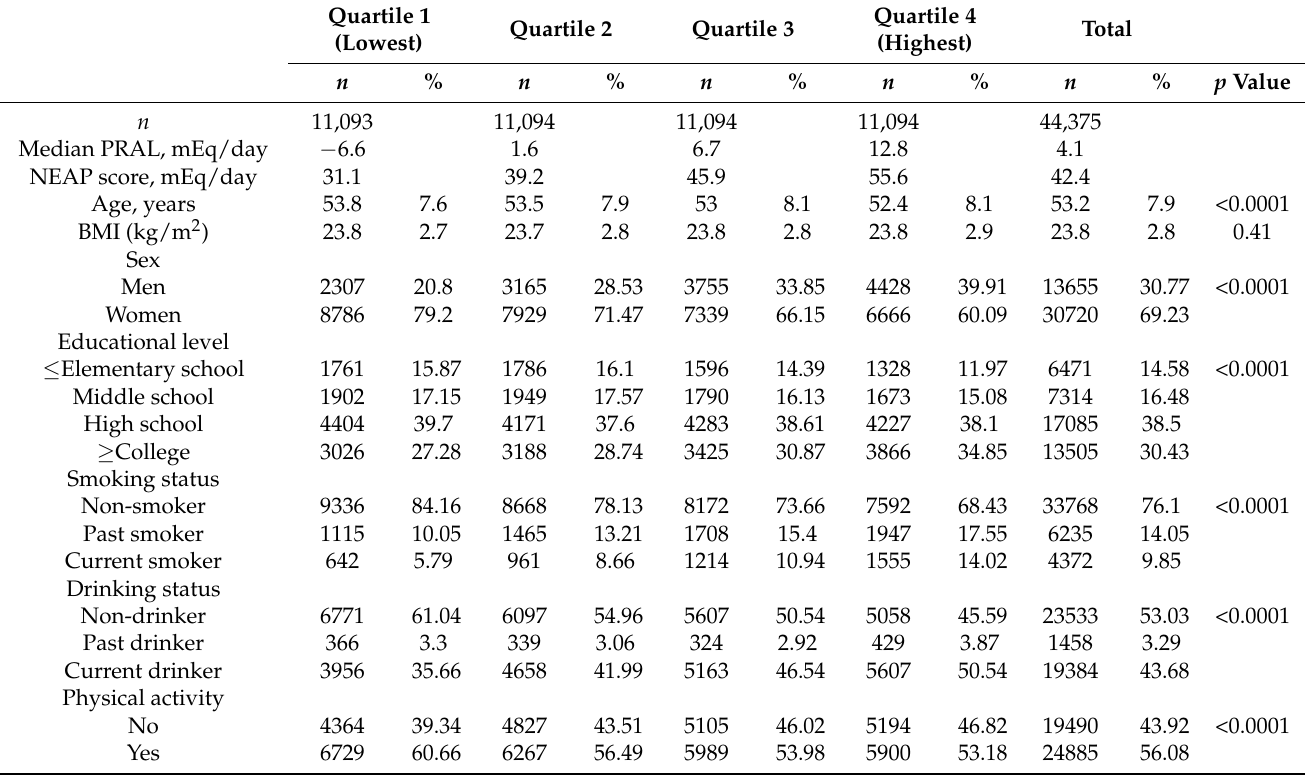
Table 1. Characteristics of the study participants at baseline according to the quartiles of the PRAL